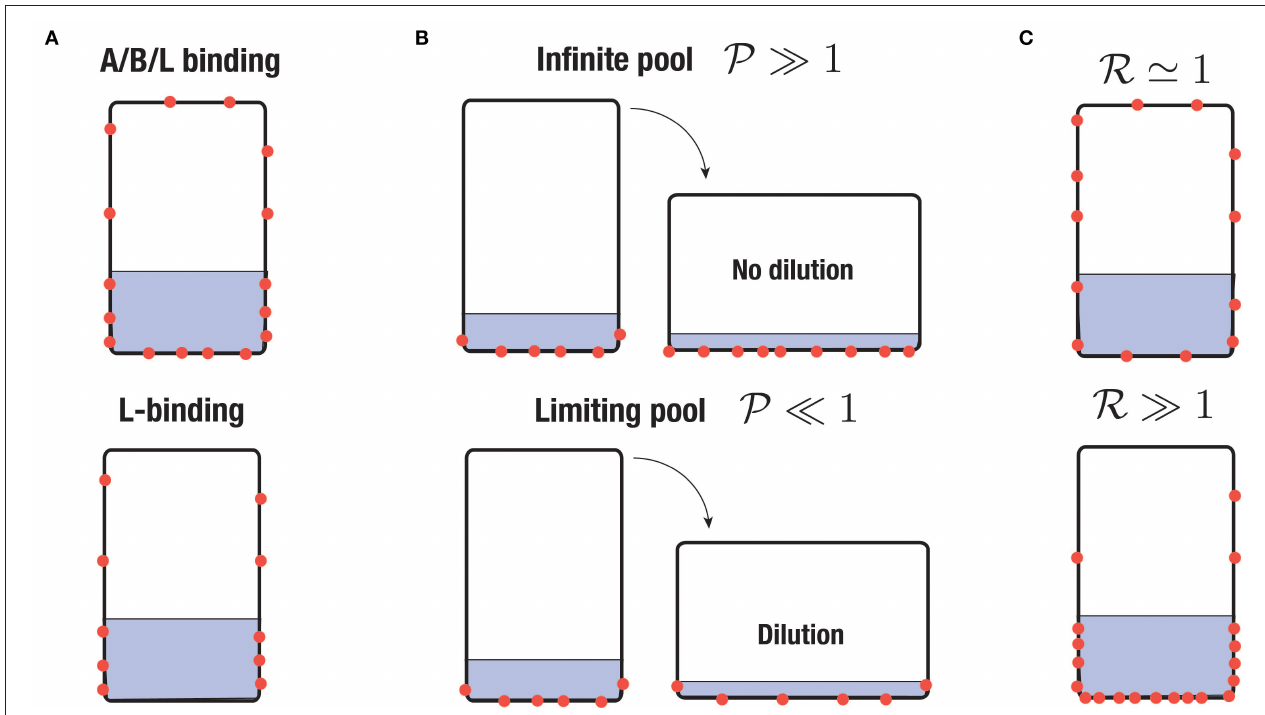
FIGURE 4 | Sketch of different scenario of PIN-binding. PINs are represented in red and the region with statoliths in gray. (A) Apical/basal/lateral (A/B/L) binding vs. lateral (L) binding. (B) Infinite pool versus limiting pool. In the first case, the surface density of PINs is conserved whereas in the second one, the total number of PINs attached to the cell membrane is conserved. (C) Low sensitivity of PIN to statoliths ( R